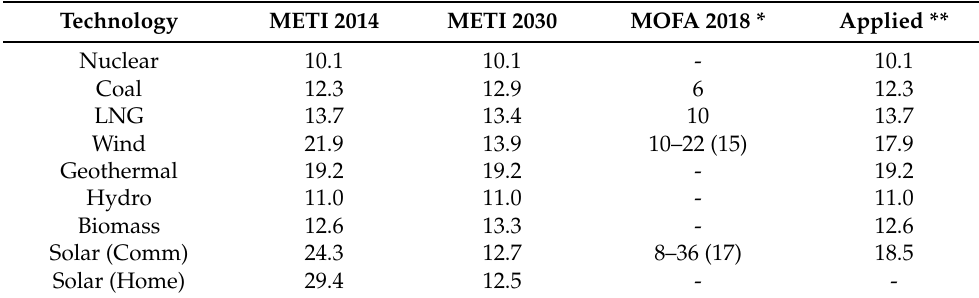
Table 7. Cost of electricity generation